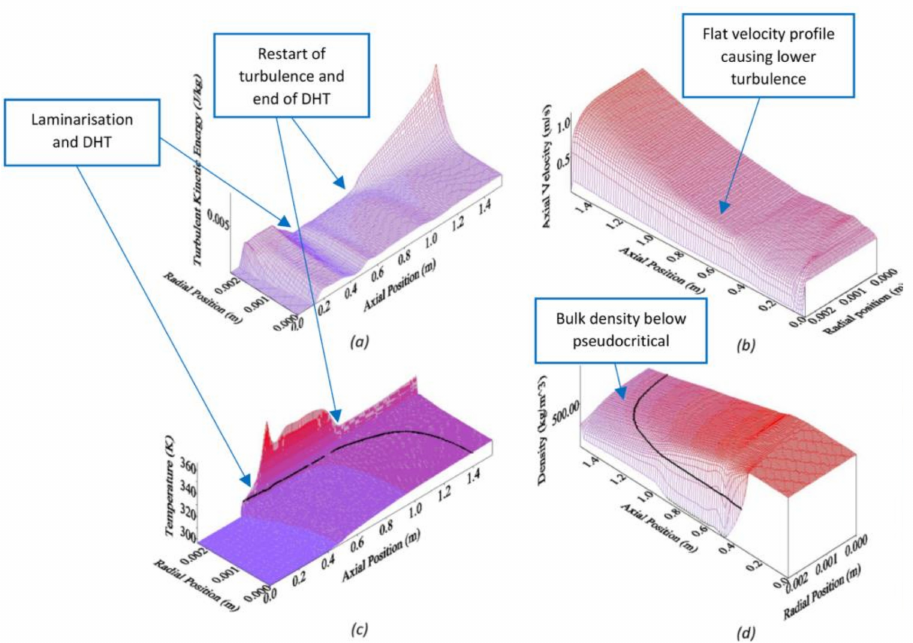
Figure 3. Sequence of changes in the turbulent kinetic energy ( a ), axial velocity ( b ), fluid temperature ( c ) and density ( d ) predicted by CFD for some of Kline’s [28] boundary conditions (CO 2 at 8.35 MPa) (adapted from reference [20] with Editor’s